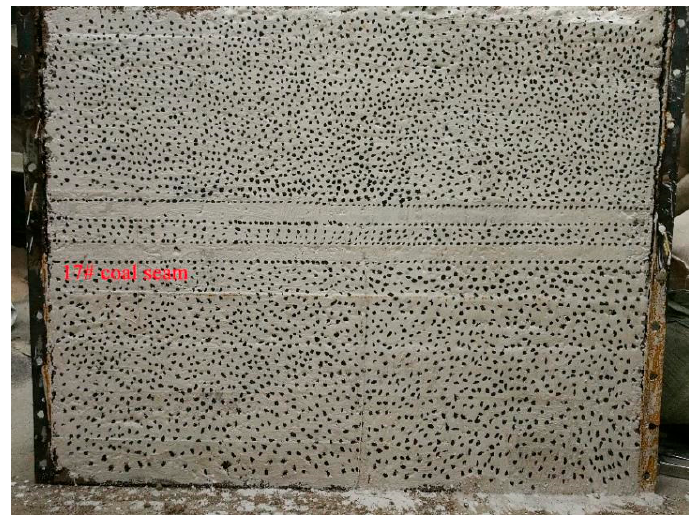
Figure 7. Similar simulation model.